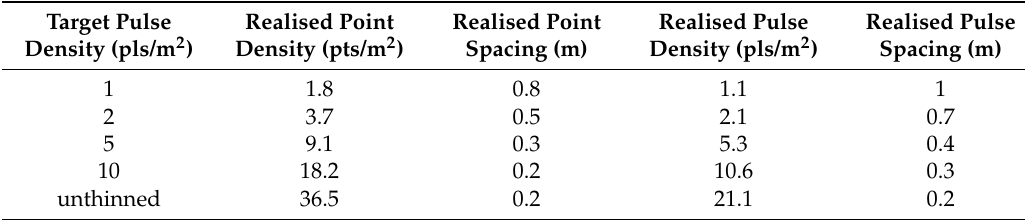
Table 3. Summary of original and thinned ALS datasets.